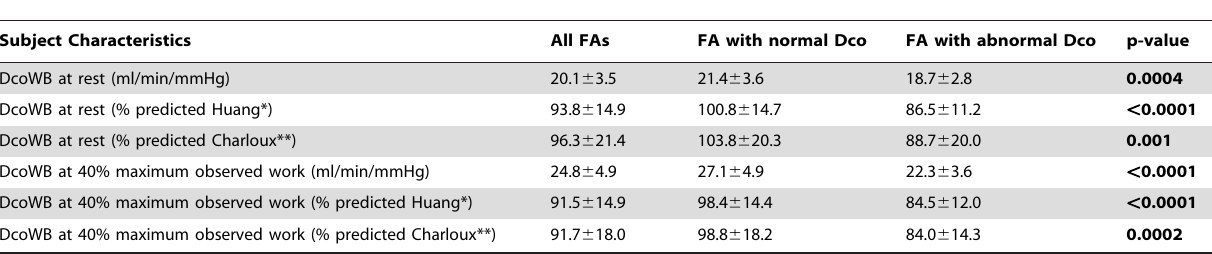
Table 3. Within-Breath Diffusing Capacity (DcoWB) at rest and with